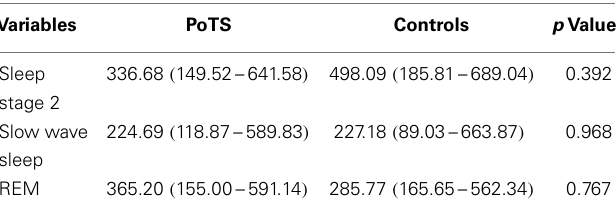
Table 5 | LF/HF ratio across different sleep stages in median with its interquartile range